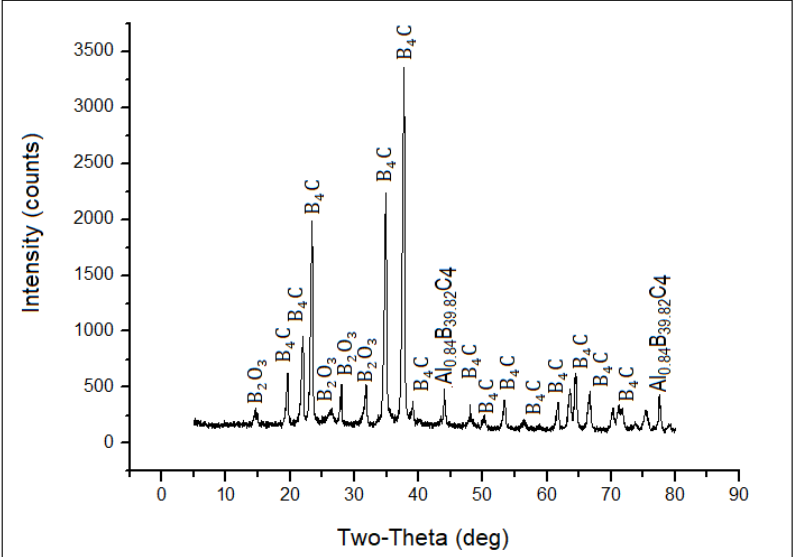
Fig. 4. XRD pattern from B 4 C